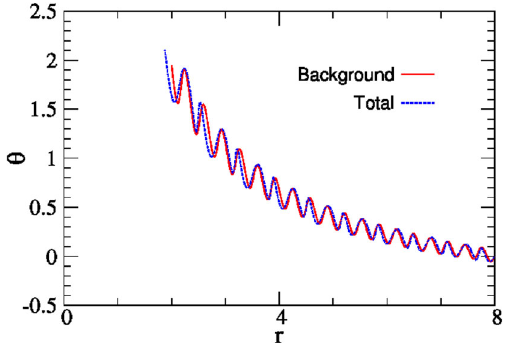
Fig. 4 Dynamics of the orientation θ of active particles with radial coordinate r ; with ω = 0 . 001 , A = 1 , B = 10 ,(cid:6) = 0 . 1. The initial conditions are x = 8 , y = 0 ,θ =